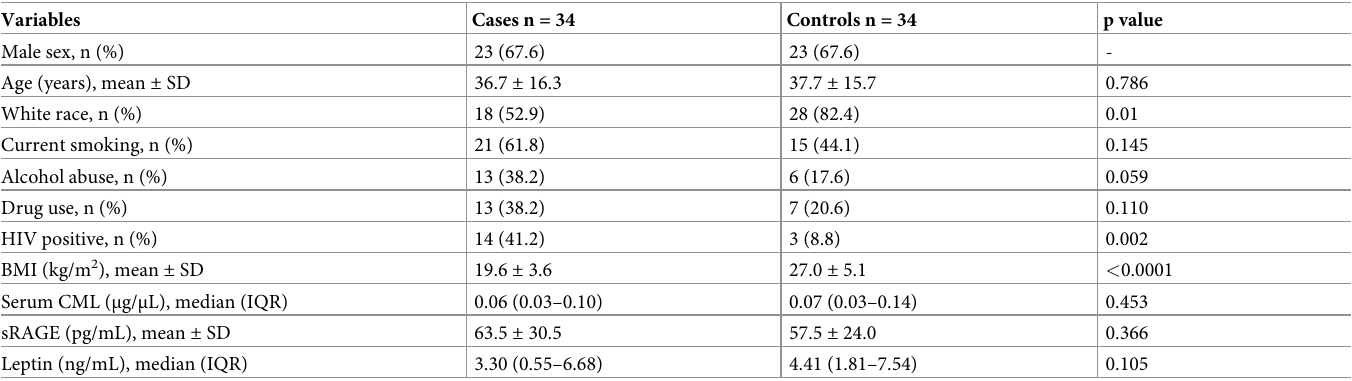
Table 1. Comparison between cases and